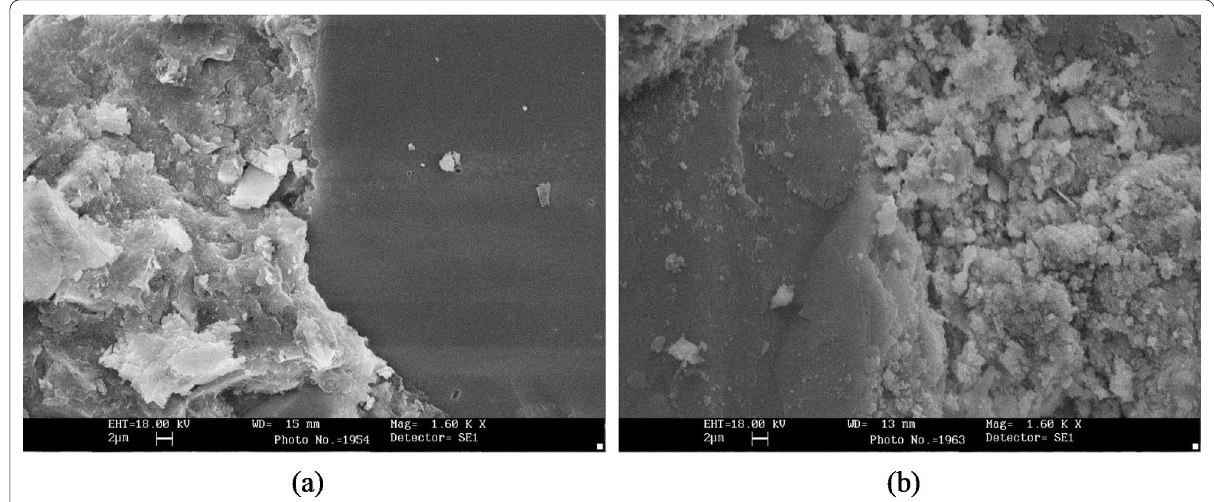
Fig. 7 Transition zone of mixes a with 1400 kg/m 3 and b 1200 kg/m 3 binder